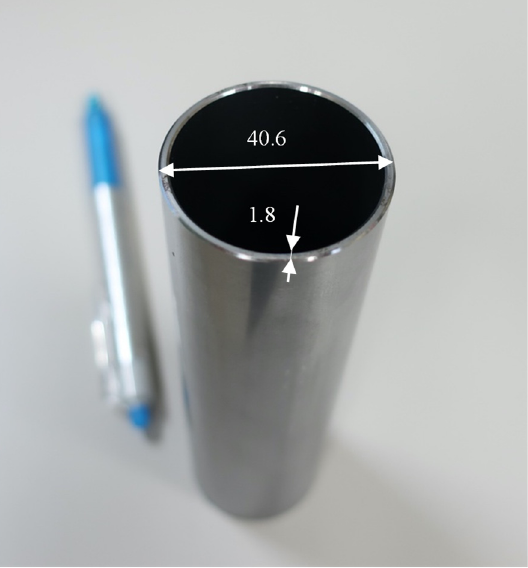
Figure 1. Steel tube appearance. Dimensions are in mm.